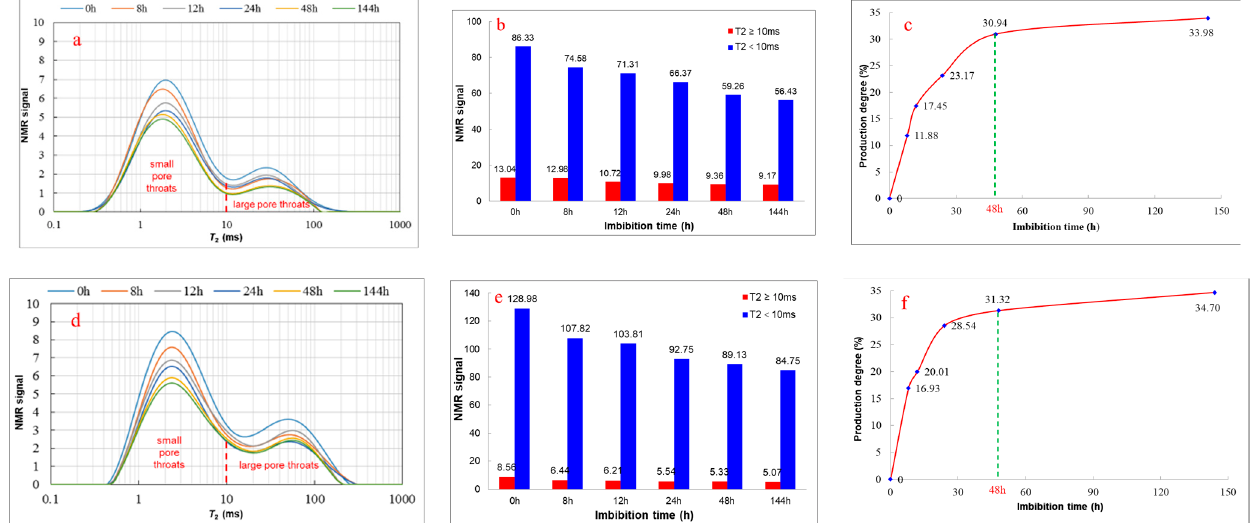
Figure 13. Imbibition NMR results of core samples of type Ⅱ reservoir; ( a , d ) are the T 2 spectrum of imbibition NMR of IR-01 and IR-10, respectively; ( b , e ) are the histogram of NMR signal at different imbibition times of IR-01 and IR-10, respectively; ( c , f ) are the variation of production degree of crude oil in the pore throats of IR-01 and IR-10, respectively.